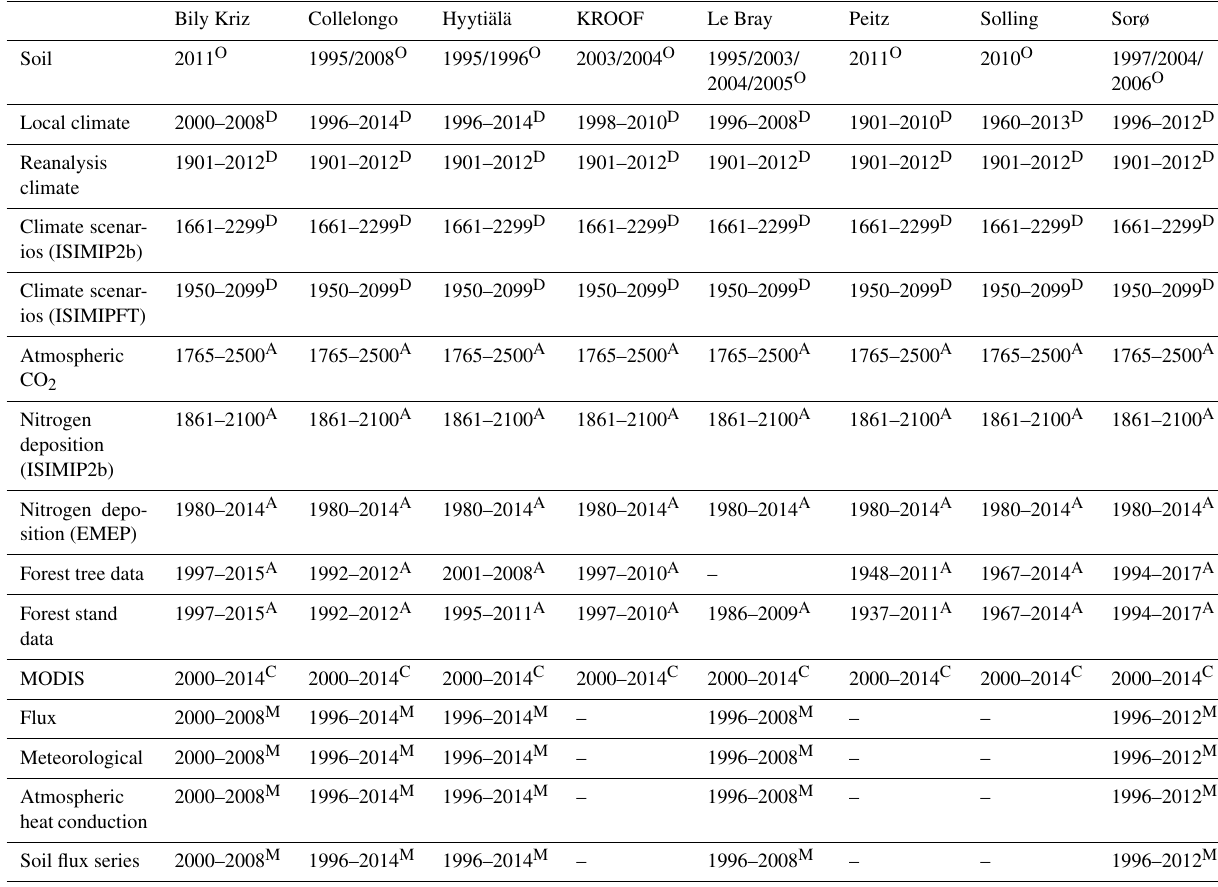
Table 1. Overview of the data available in the PROFOUND DB. The years indicate the first and the last years for which data are available except for one-off measurements. The superscript letters indicate the temporal resolution of the data. O: one-off measurement(s); M = 30min measurements; D: daily measurements; C: 8d or 16d composite; A: annual measurements. Bily Kriz Collelongo Hyytiälä KROOF Le Bray Peitz